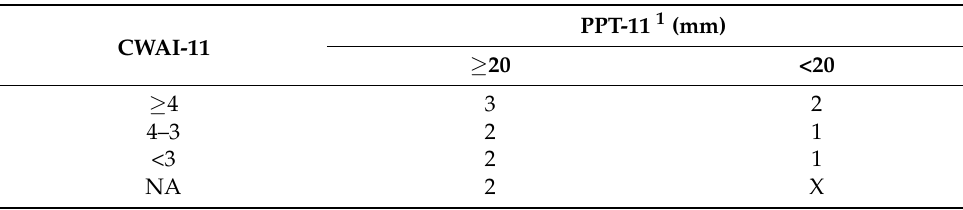
Table 3. Decision matrix for alert level determination for cases where both values of CWAI-1 and CWAI-6 are not